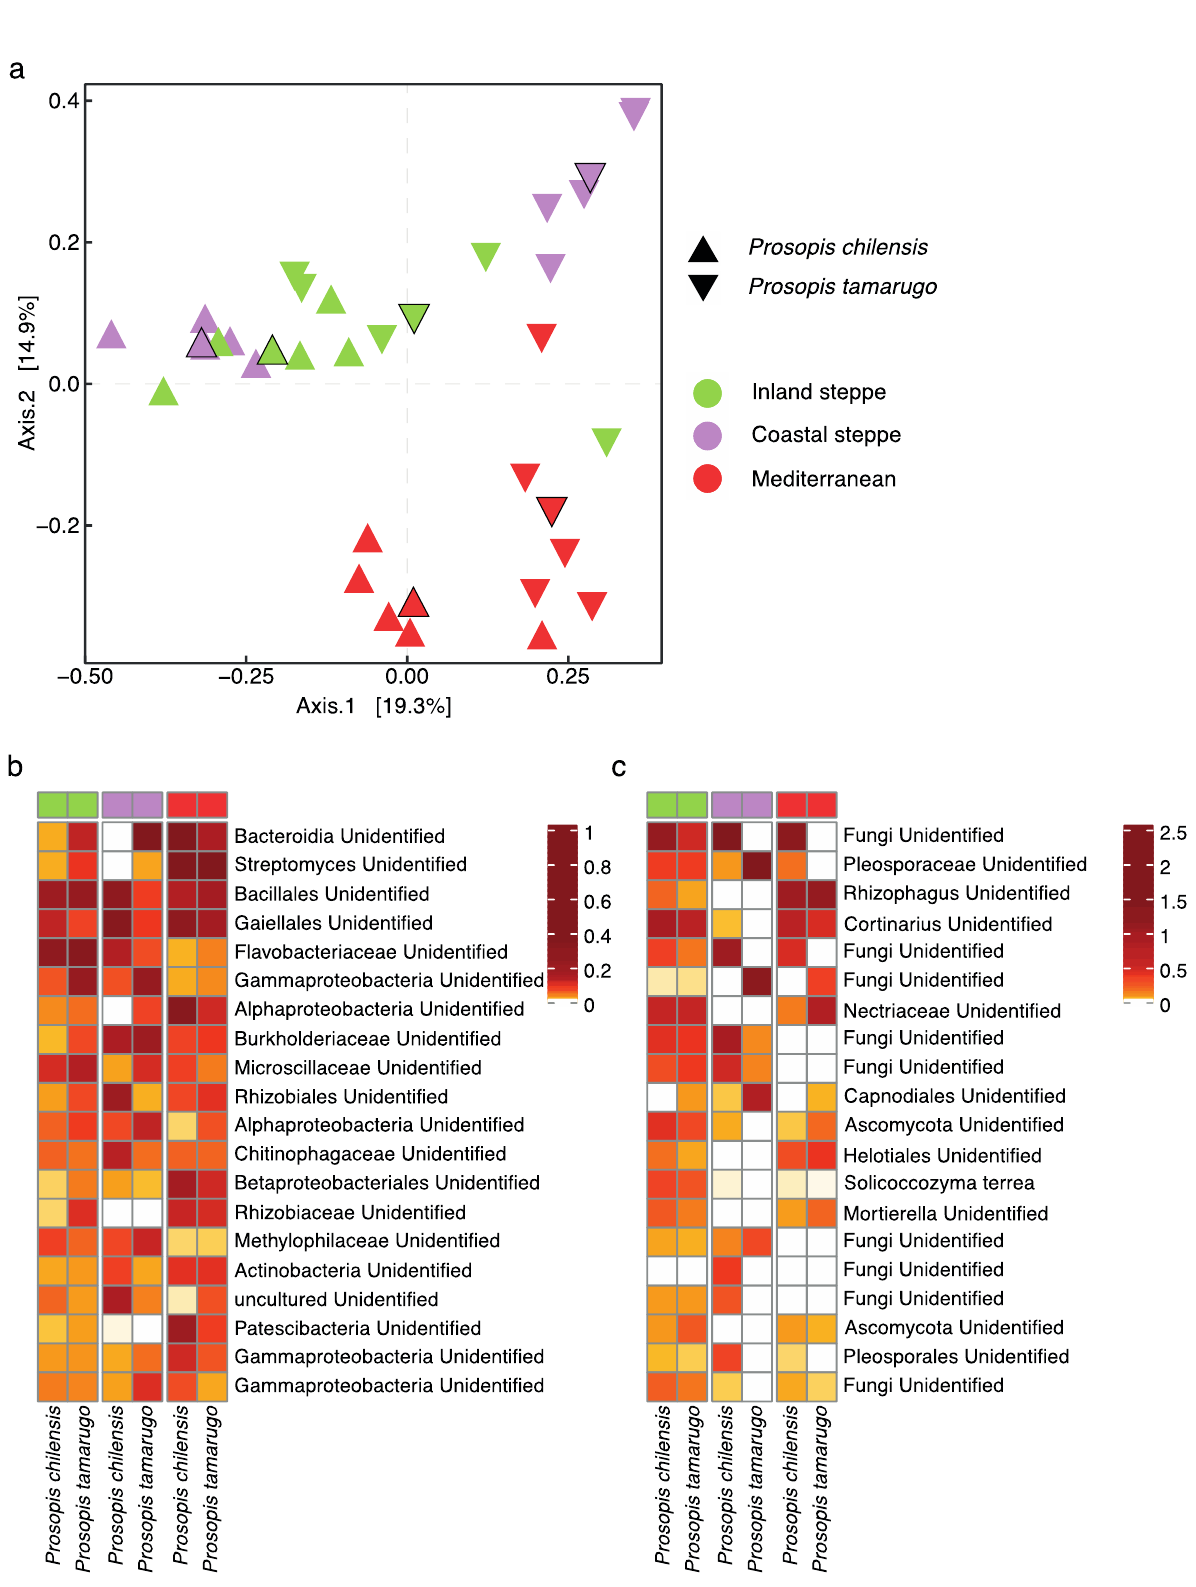
Figure 5. Principal coordinate analysis (PCoA) of the microbial community composition of soil samples ( a ). Black bordered shapes correspond to the group centroid. Heatmaps showing the top 20 bacterial ( b ) and fungal ( c ) ASVs that drove the community differences. Color scale was grouped by quintiles for visualization purposes. See Tables S6 and S7 for dissimilarity analysis. Table 2. Bacterial and fungal root-associated community by Prosopis chilensis and P. tamarugo rela- tive to the ASV abundance in the soil. ASVs with higher abundance in the roots were considered as